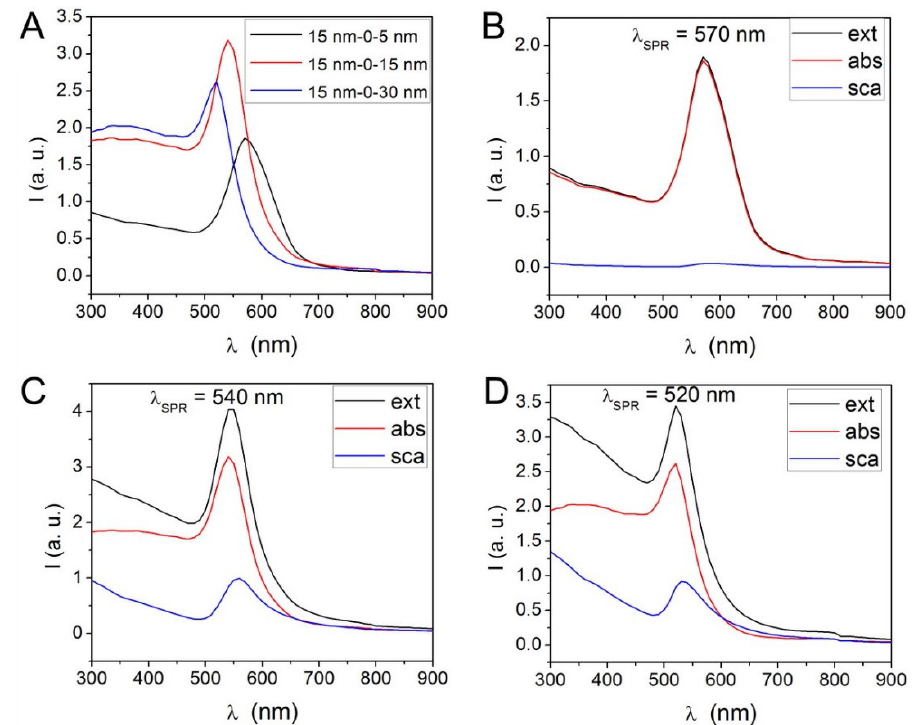
Figure 4. DDA simulation results I ( λ ), referring to the wavelength-dependence of extinction (ext), absorption (abs), and scattering (sca). ( A ) The extinction curves of UCNP-Au NPs with different Au NP shell sizes, with geometry R 1 -0- Z . The contribution of absorbance and scattering to the extinction curves is shown for ( B ) 15 nm–0–5 nm, ( C ) 15 nm–0–15 nm, and ( D ) 15 nm–0–30 nm geometry.